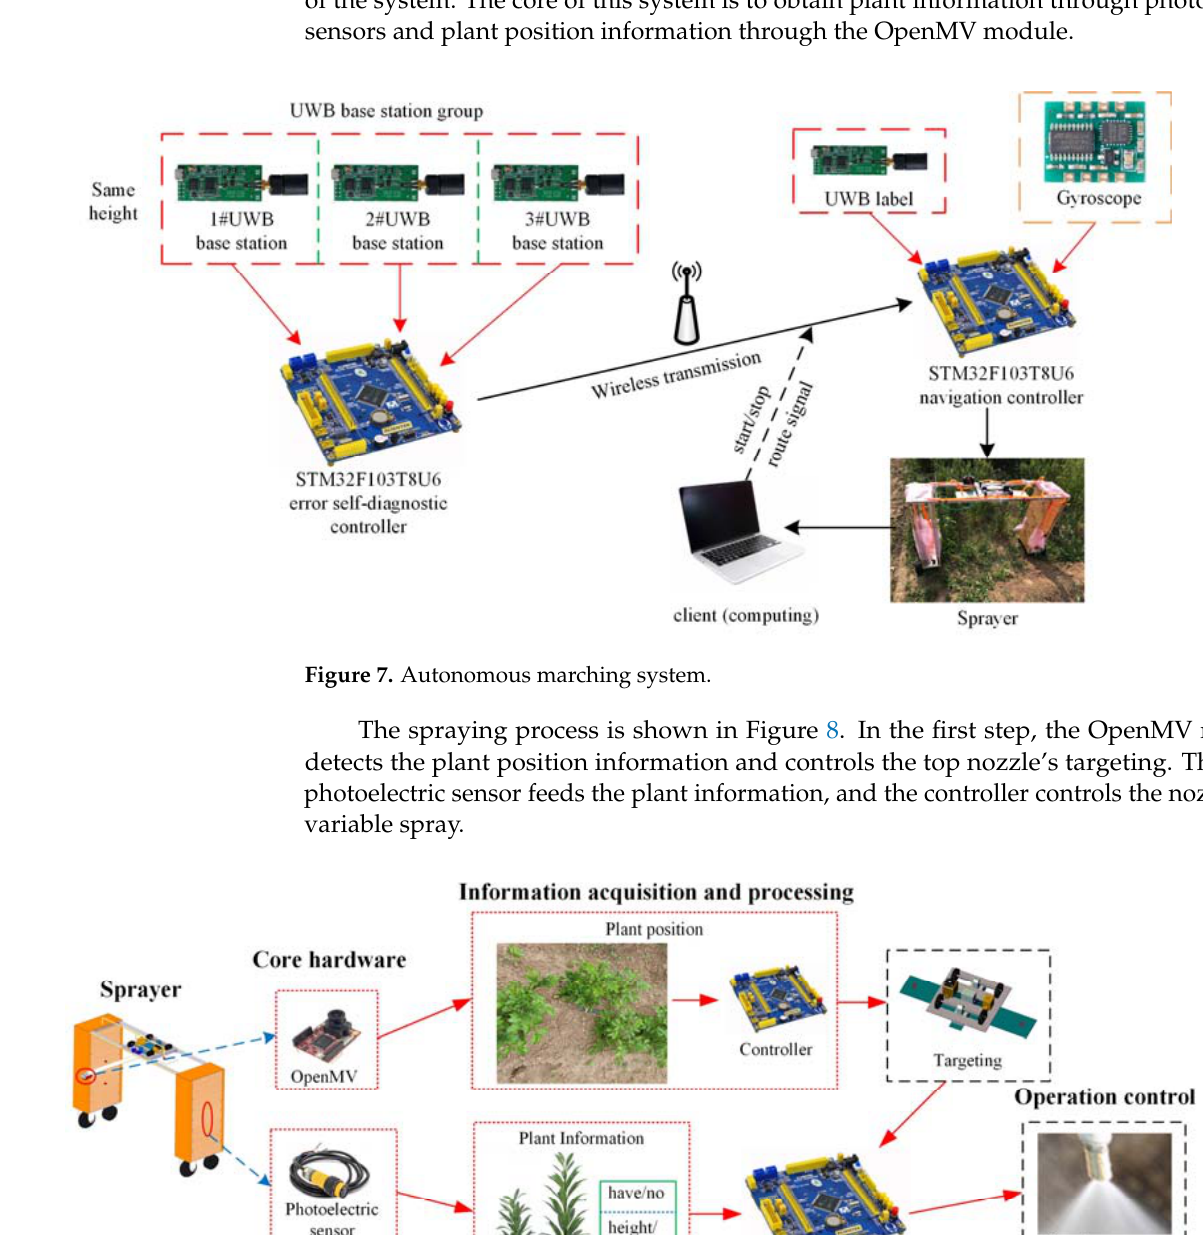
Table 3. Photoelectric sensors’ speci fi c feedback signal.